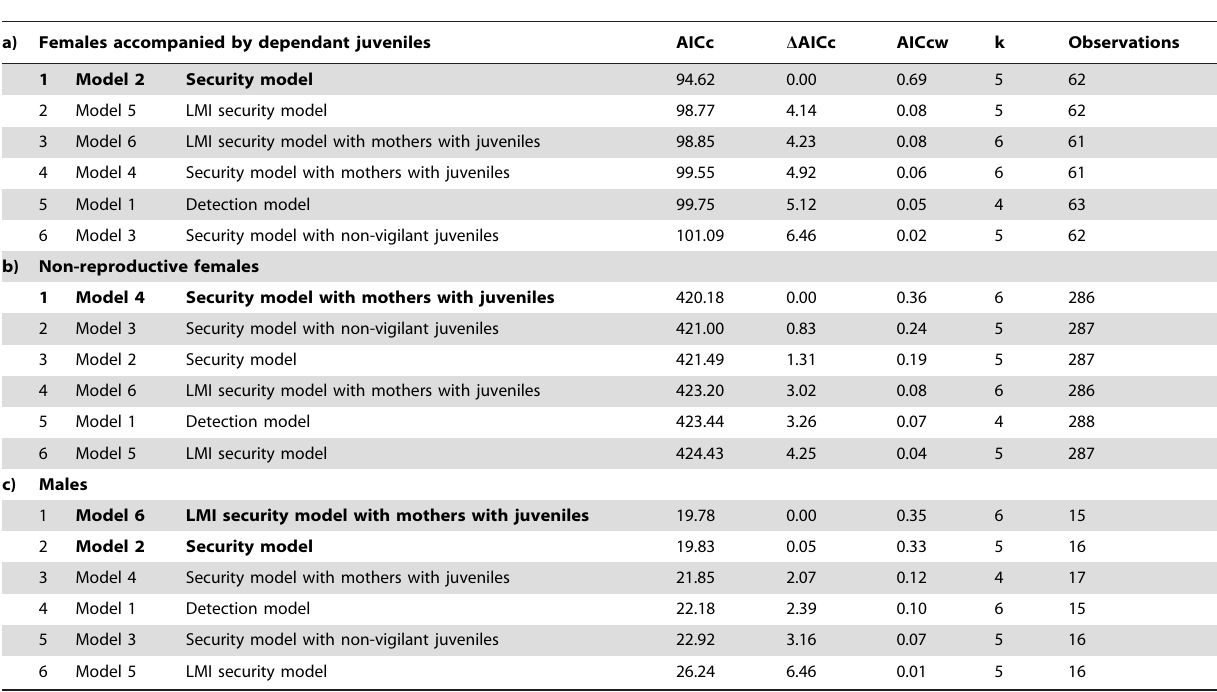
The best-fitting model for each category is presented in bold.